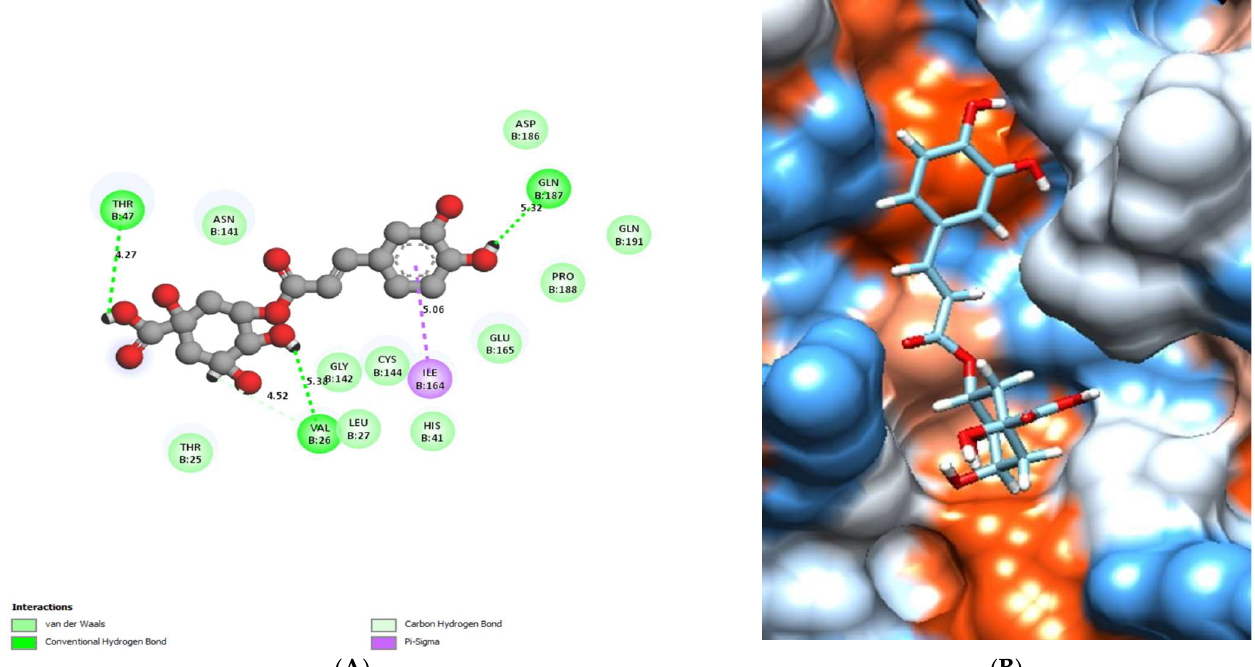
Figure 13. Chlorogenic acid docked in HCo-V229E main protease hydrogen bonds are represented in green lines ( A ), with the mapping surface showing chlorogenic acid occupying the active pocket of HCo-V229E main protease ( B